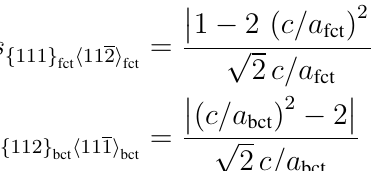
(cid:104) 111 (cid:105) bct bct